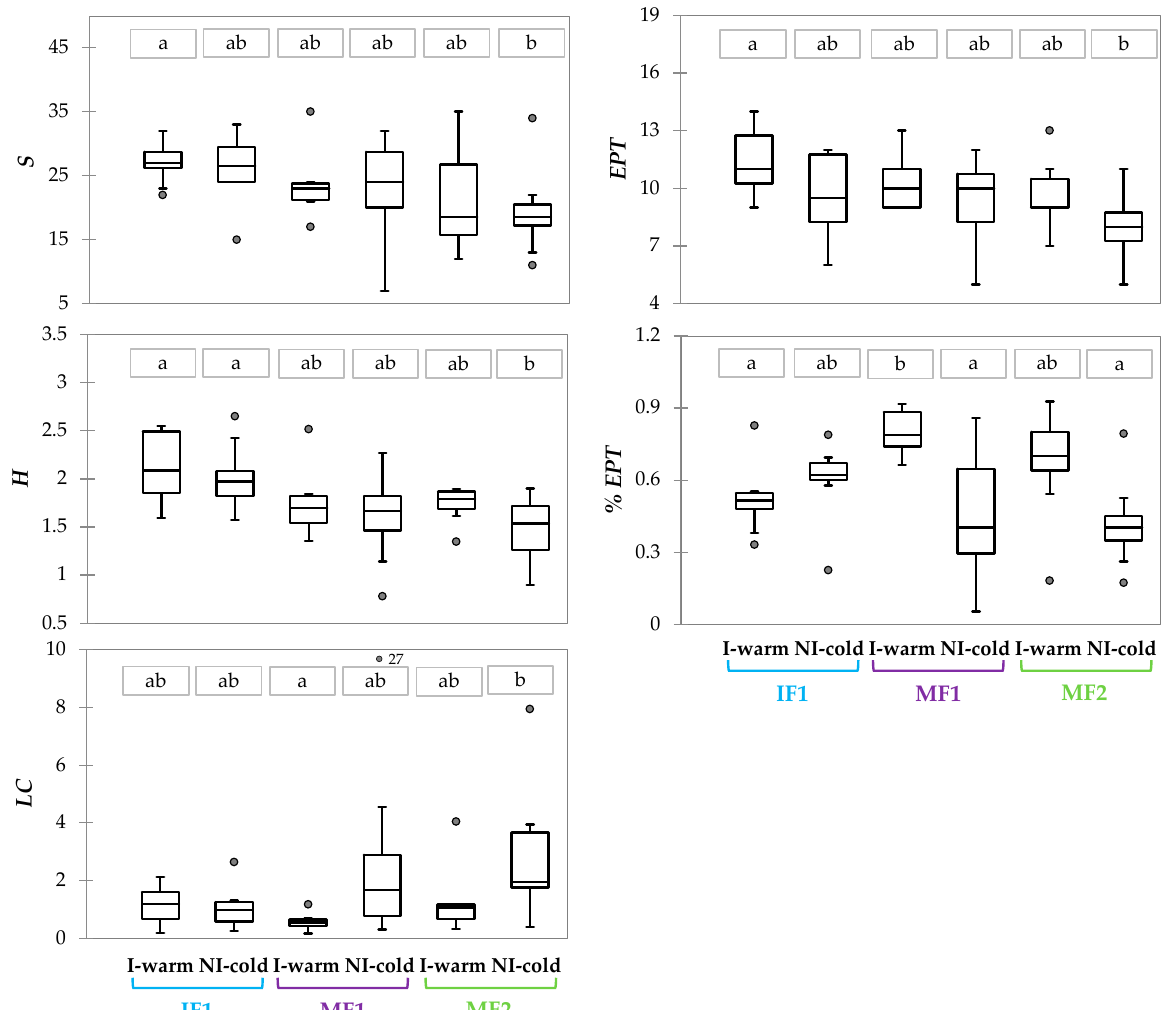
Figure 5. Box plots of the biological metrics which resulted significantly different between site*period sample groups. Different letters above the boxes indicate significant differences between groups (Kruskal–Wallis and Dunn test, p < 0.05). Dots indicate outliers.